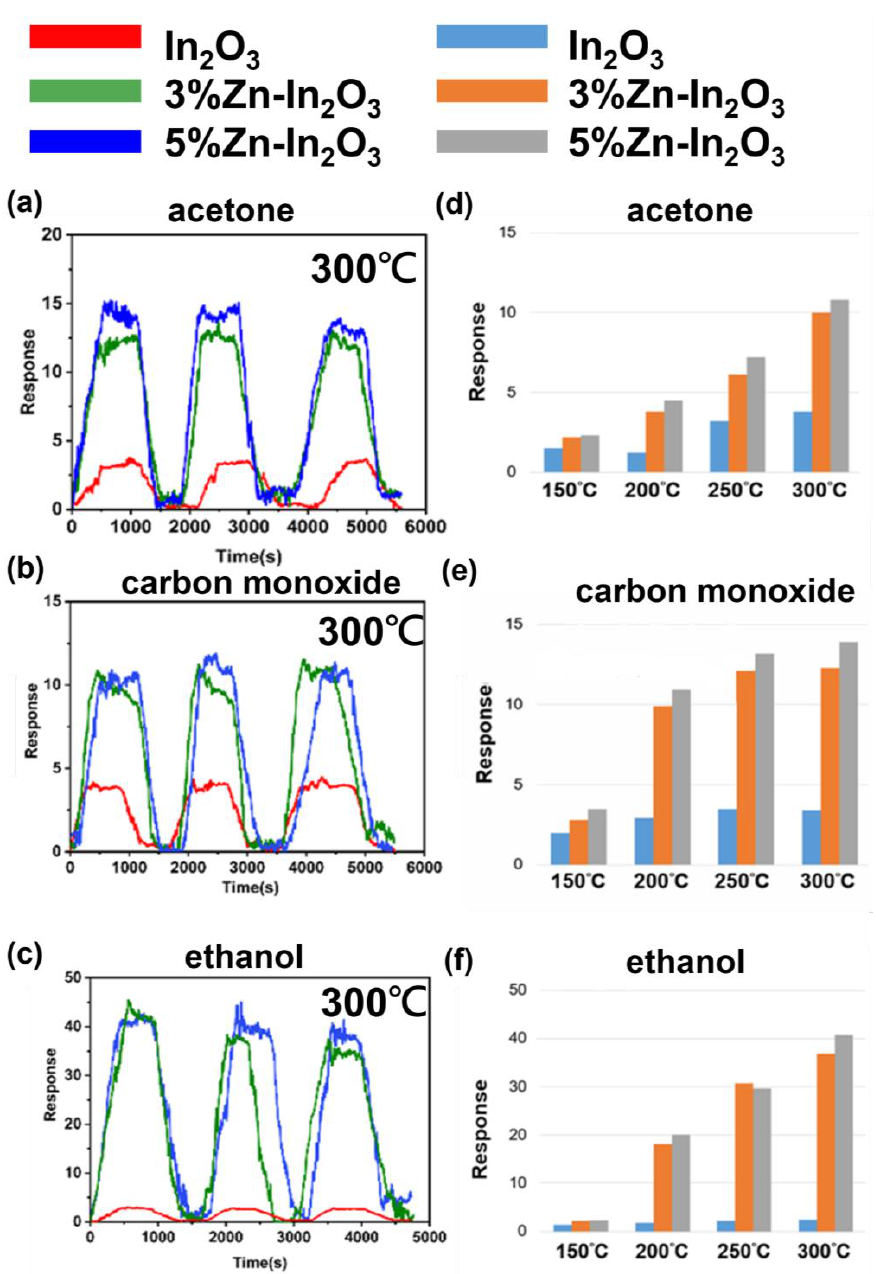
Figure 7. Dynamic responses at 300 °C of In 2 O 3 , 3 at% Zn-In 2 O 3 and 5 at% Zn-In 2 O 3 nanowires to 5 ppm of ( a ) acetone, ( b ) carbon monoxide, and ( c ) ethanol at optimal operating temperature, and bar graphs for different temperatures. Responses of In 2 O 3 , 3 at% Zn-In 2 O 3 and 5 at% Zn-In 2 O 3 nanowires to 5 ppm of ( d ) acetone, ( e ) carbon monoxide, and ( f ) ethanol at temperatures of 150–300 °C.